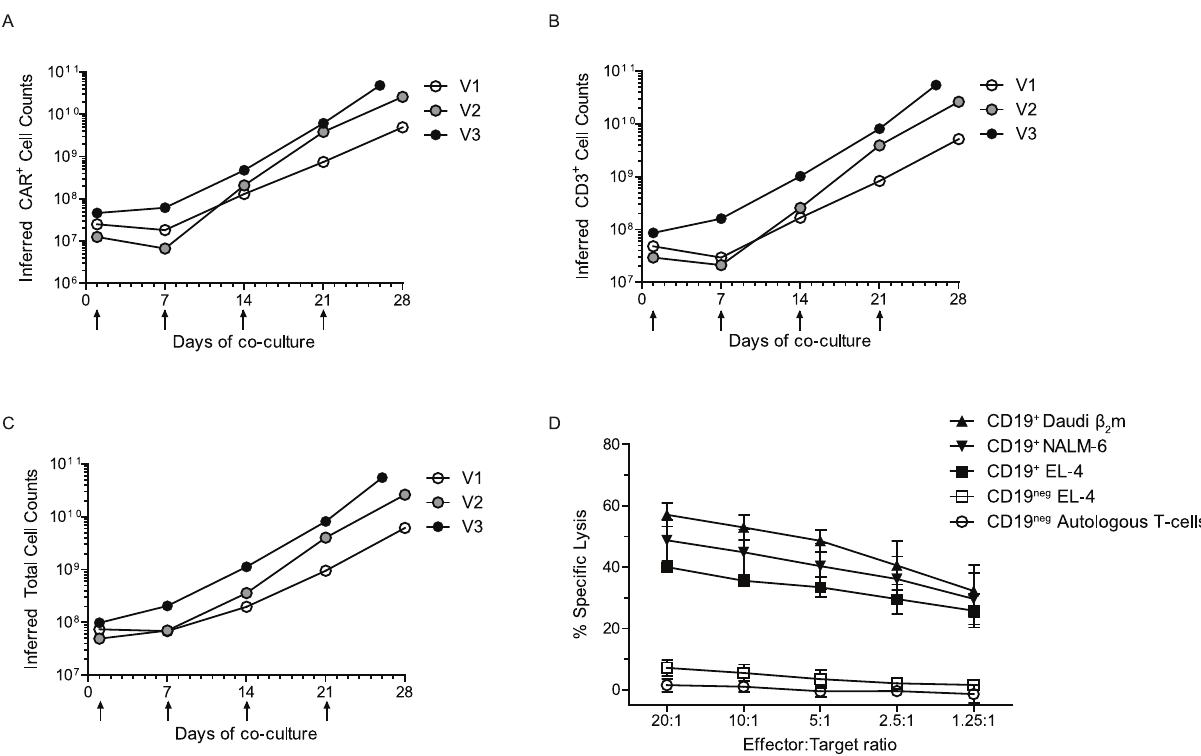
Figure 4. Expansion kinetics and redirected specificity of CAR + T cells. Genetically modified T cells were co-cultured with aAPC clone # 4 for 28 days. At the end of each stimulation cycle (7 days), cells were counted and stained for expression of CAR and CD3. Three validation runs (V1, V2, and V3) were performed and the graphs represent inferred (A) CAR + T cells, (B) CD3 + T cells, (C) Total viable cells over time. Arrows indicate addition of aAPC to the culture. (D) Lysis of CD19 + targets (Daudi b 2 m, NALM-6, CD19 + EL-4) as compared to background lysis of CD19 neg EL-4 using 4-hr chromium release assay by CAR + T cells. Mean 6 SD of three validation runs is represented. doi:10.1371/journal.pone.0064138.g004 compared to CD4 + CAR + T cells (16 6 24%, mean 6 SD) ( Figure 3C ) which was predicted by inclusion of IL-21 [11].